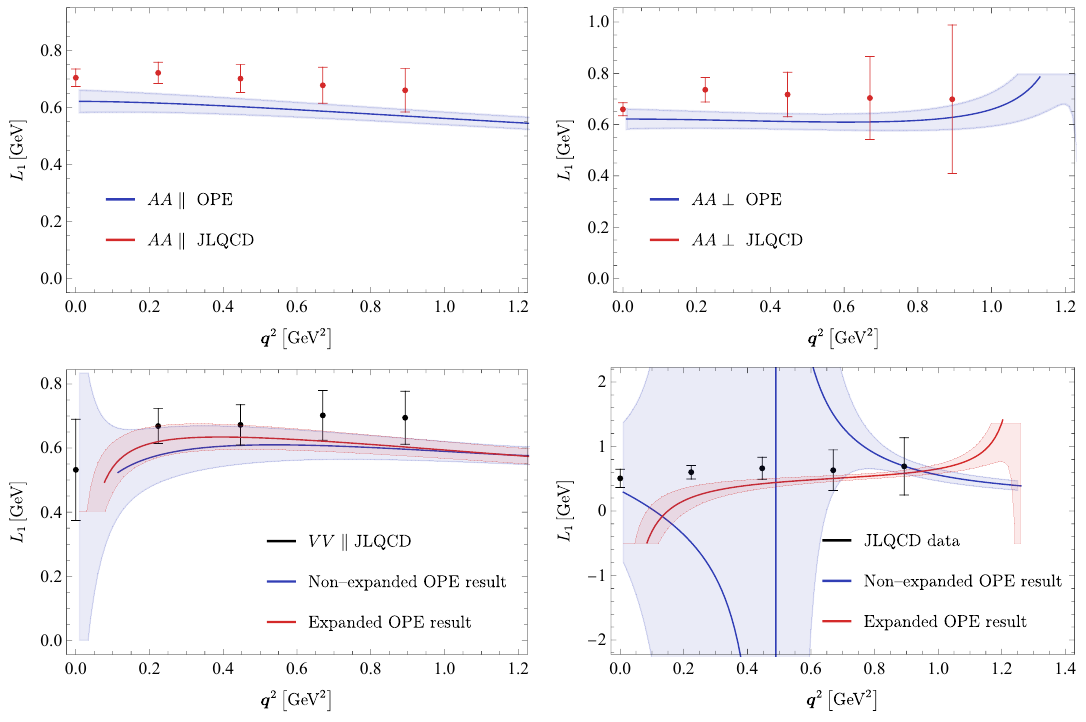
Figure 18 . Differential first leptonic moment in the various channels. The plot shows the comparison between OPE and JLQCD